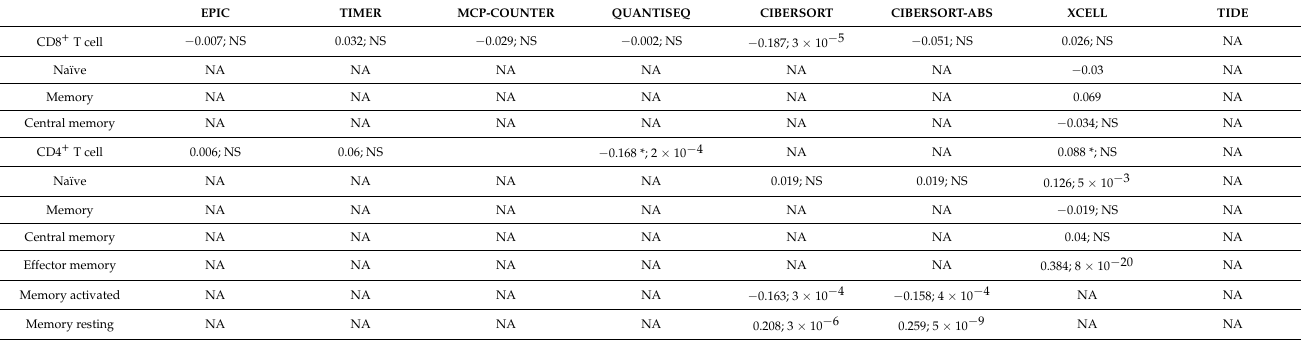
Table 4. Associations between the levels of expression of IL-37 and those of infiltration by certain immune cell types in LUAD tumors, as attested in 515 specimens. Spearman’s r values are reported. For significant associations, p -values are also mentioned. Tumor purity filter was applied. Data were obtained from www.timer.cistrome.org, (accessed on 24 August 2022) [36].